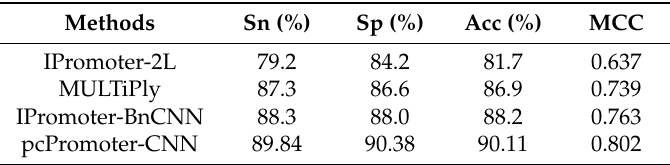
Table 4. Promoter and non-promoter identification comparison using five-fold cross-validation on benchmark dataset.